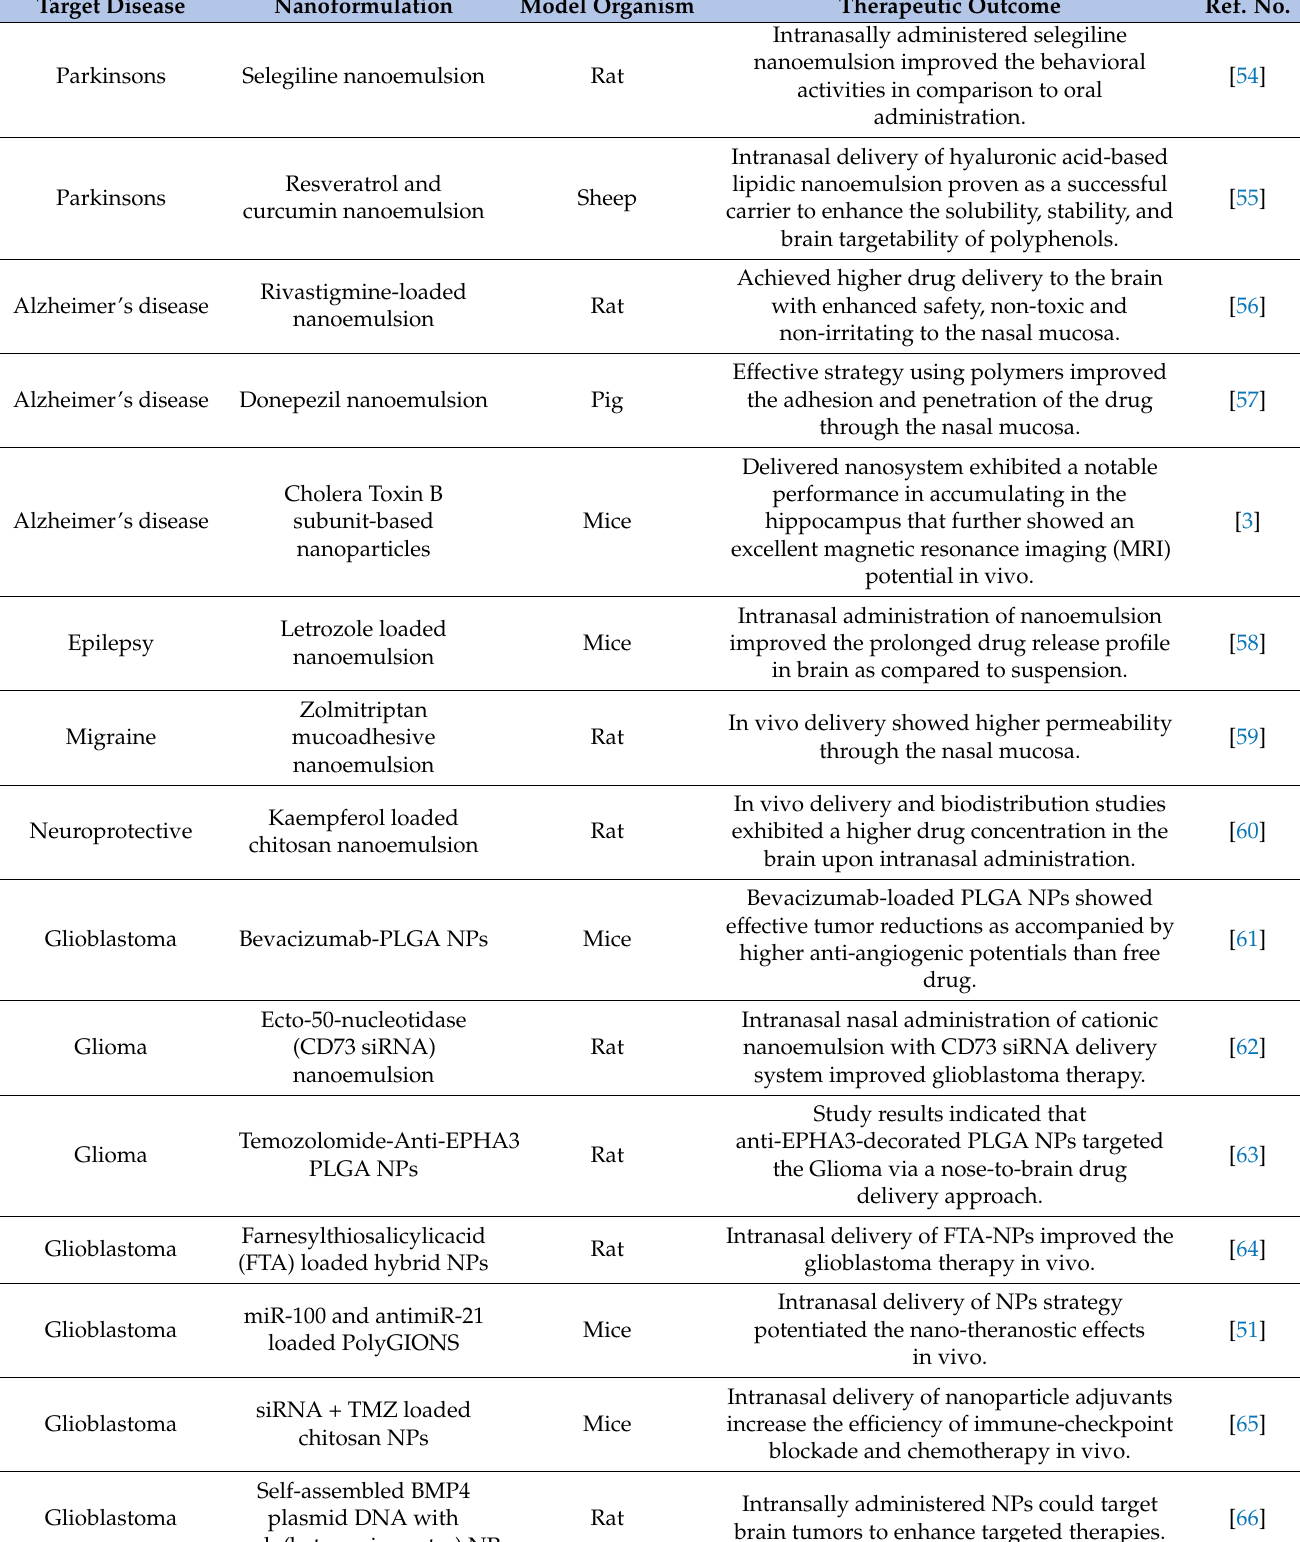
Table 1. A list of functionalized theranostic nanoformulations developed to deliver therapeutics for brain-related diseases